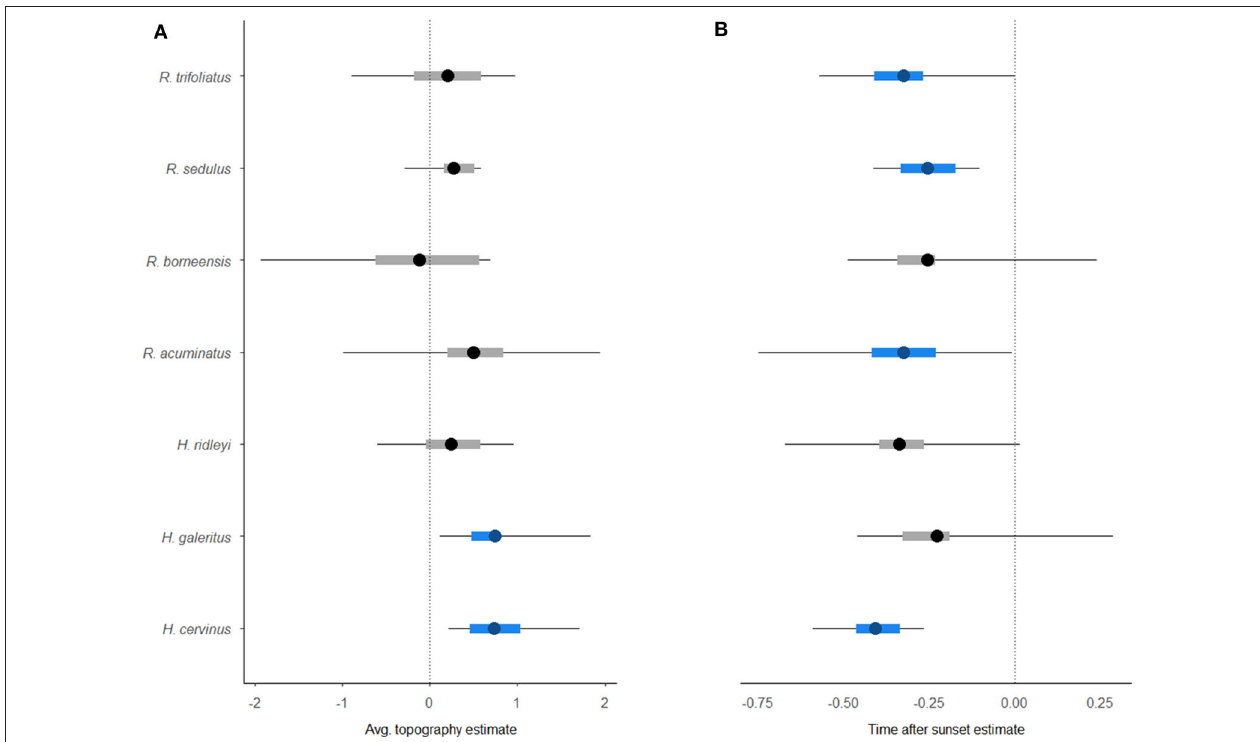
FIGURE 4 | Caterpillar plots of the output from the hierarchical Bayesian multi-species occupancy model [4] (including 95% Bayesian credible interval). Graphs show species-specific baseline occupancy estimates for environmental covariates (A) Topography , and (B) detection covariate TimeafterSunset . Significant associations are highlighted in